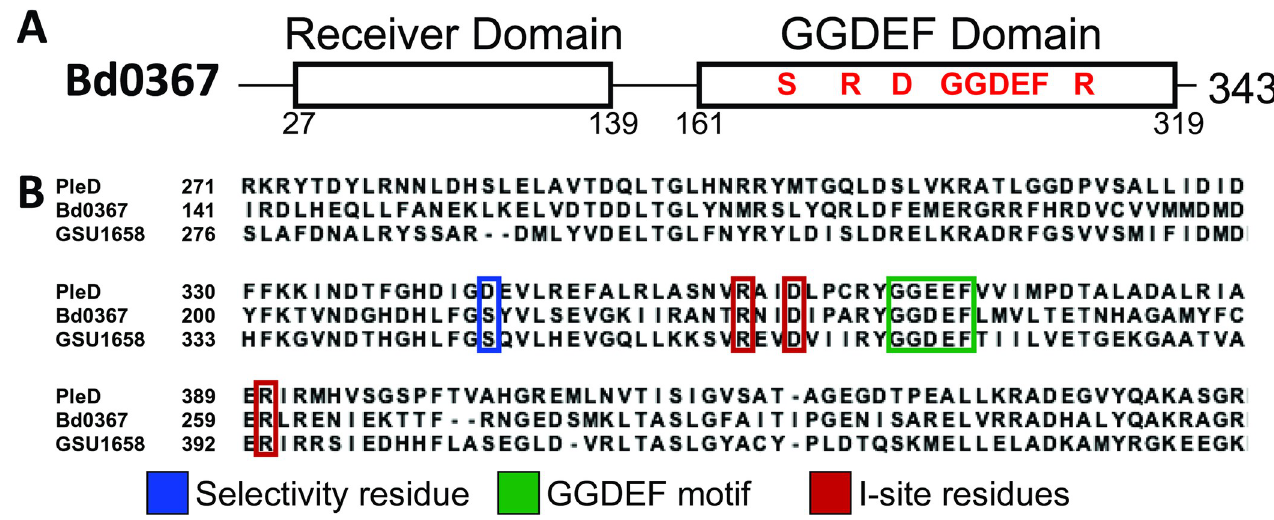
Fig 1. Bioinformatic analysis of Bd0367. A- Diagrammatic representation of the domains of B . bacteriovorus Bd0367. B- Alignment of the primary amino acid sequence of the GGDEF domains of Caulobacter vibriodes (CB15) PleD, Bdellovibrio bacteriovorus Bd0367, and Geobacter sulfurreducens GacA (GSU1658). The selectivity residue (blue) differs in the Hypr proteins (Bd0367 and GSU1658) where a serine residue is present, compared to the aspartate residue at position 344 in a canonical GGDEF enzyme such as PleD. Residues involved in the GGDEF domain (green) and I-site domains (red) are also